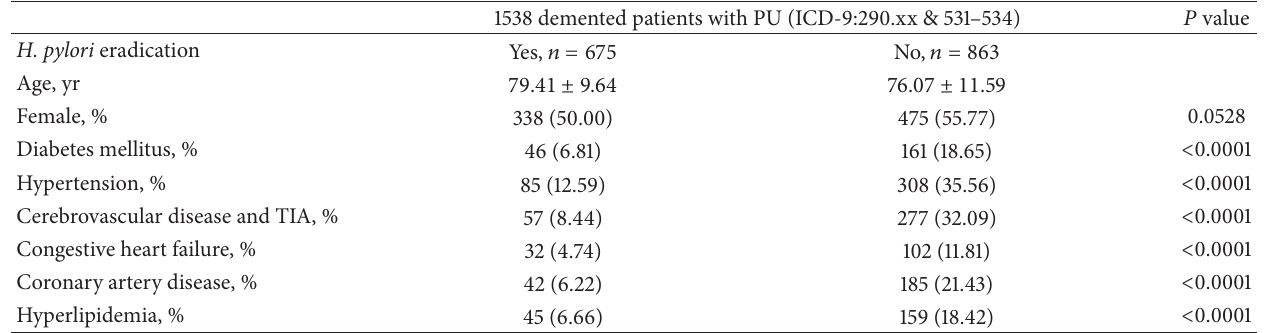
Table 1: Basic demographic data of demented patients with peptic ulcer.